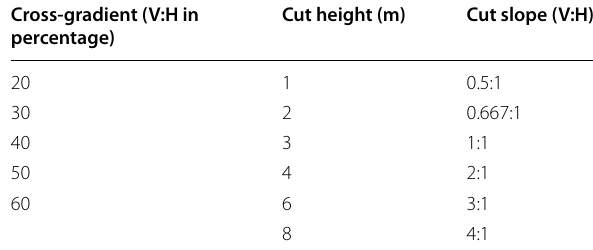
Table 3 Slope geometry information